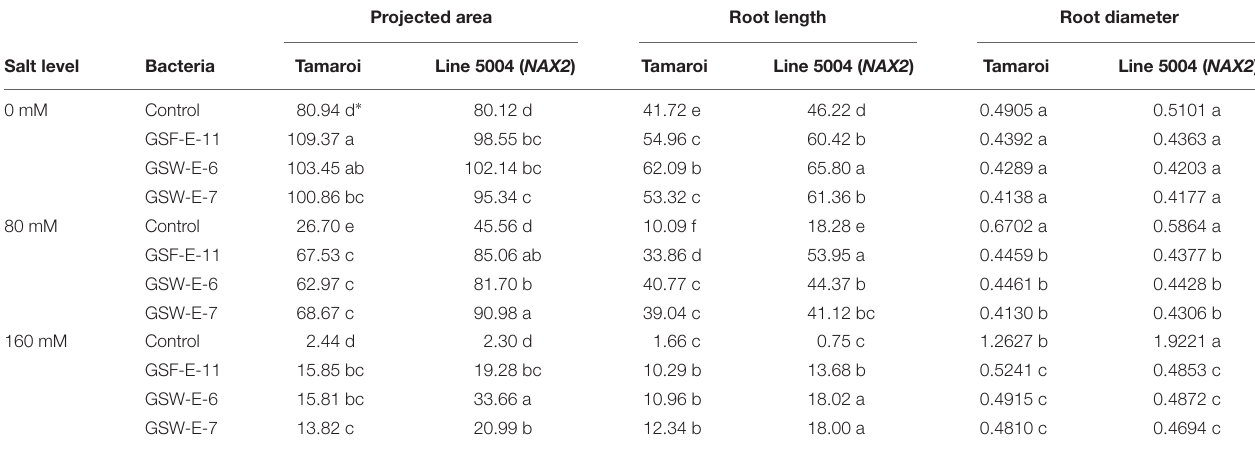
TABLE 2 | Effect of inoculation with three halotolerant bacterial strains, GHD-E-12, GSF-E-11 and GSW-E-7, on root characteristics [projected area (mm 2 ), length (mm), surface area (mm 2 ), and root diameter (mm)] in two durum wheat genotypes under different salinity levels. Projected area Root